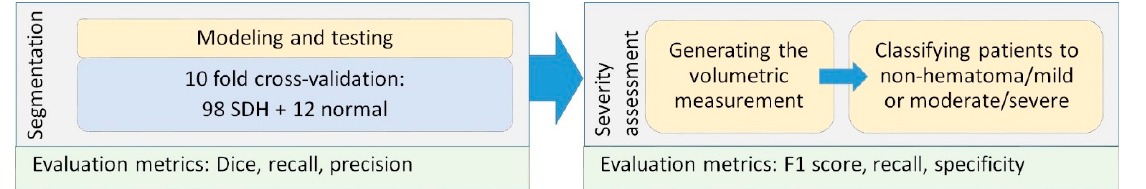
Figure 1. Experimental design and evaluation strategy for subdural hematoma (SDH) segmentation and severity assessment.